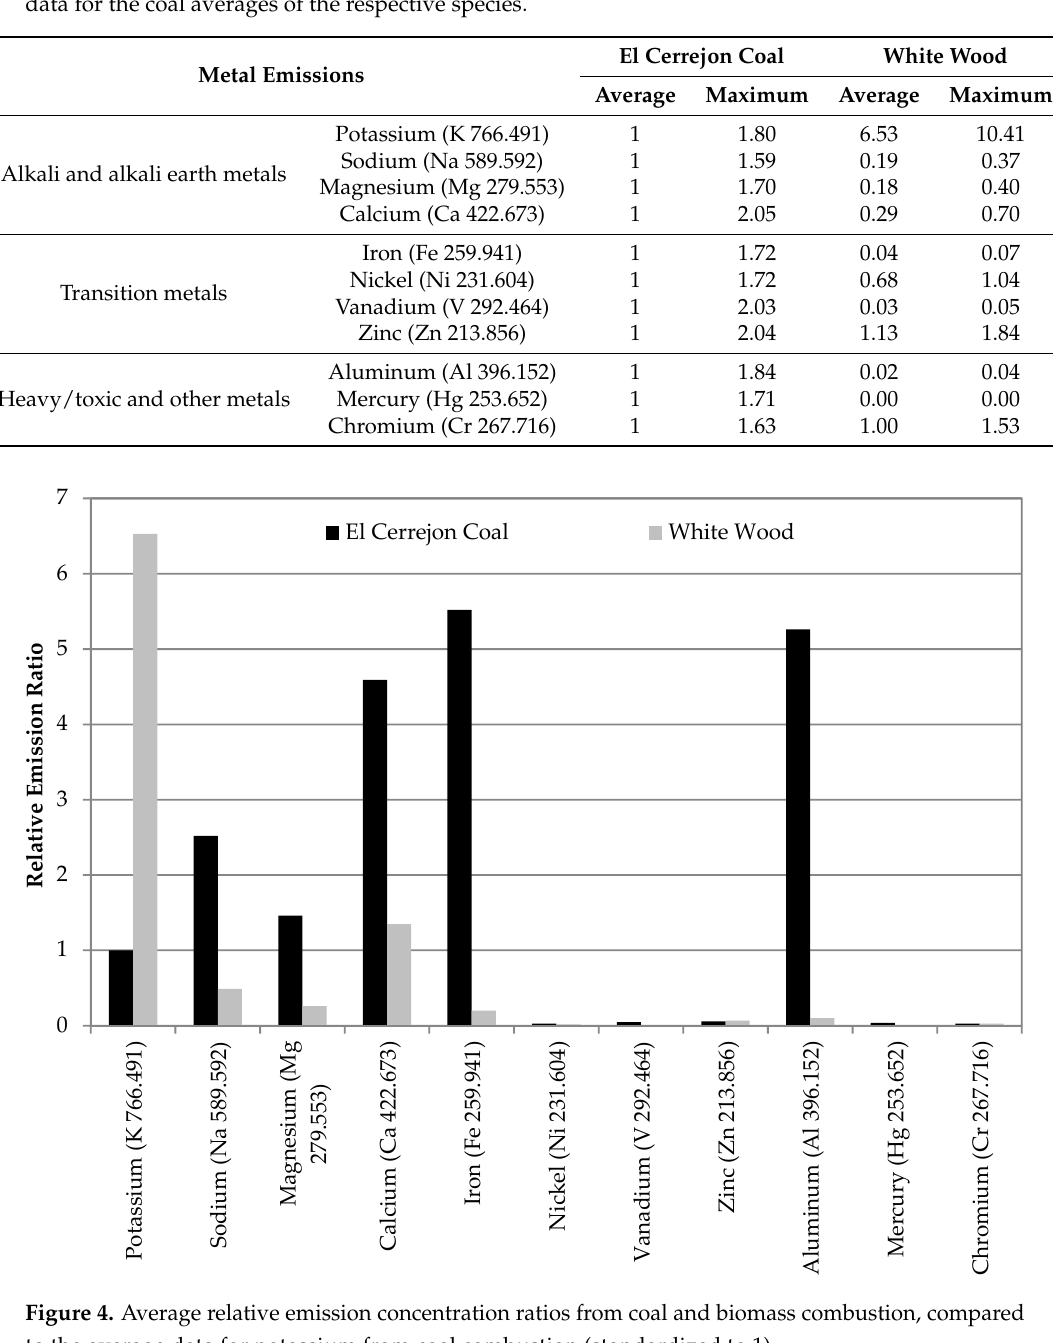
Table 5. Relative emission concentration ratios from coal and biomass combustion, compared to the data for the coal averages of the respective species.